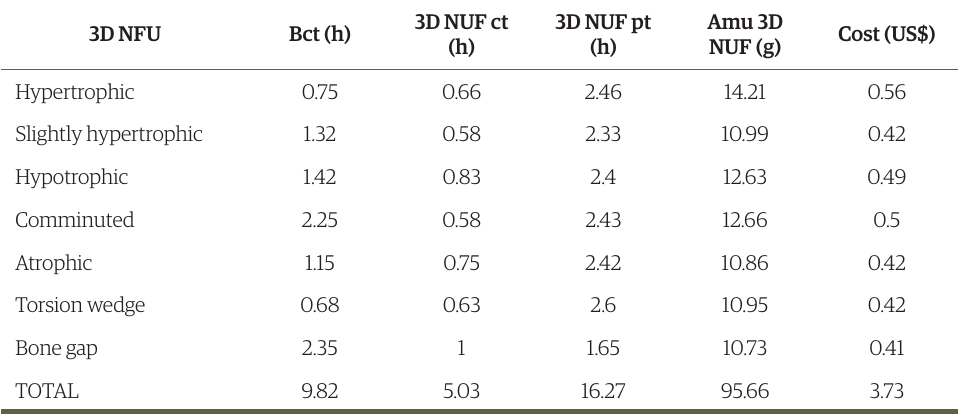
Table 2. Biscuit creation time (Bct), 3D NUF creation time (3D NUF ct), 3D NUF printing time (3D NUF pt), Amount of material used for 3D NUF (Amu 3D NUF) and Cost of 3D